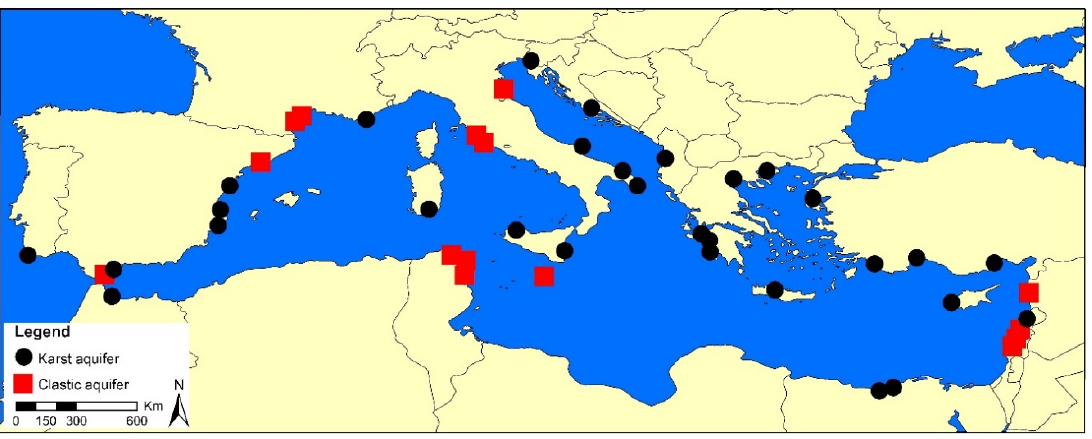
Figure 2. The main Mediterranean coastal aquifers highly affected by groundwater quality degradation due to seawater intrusion and anthropogenic contamination.